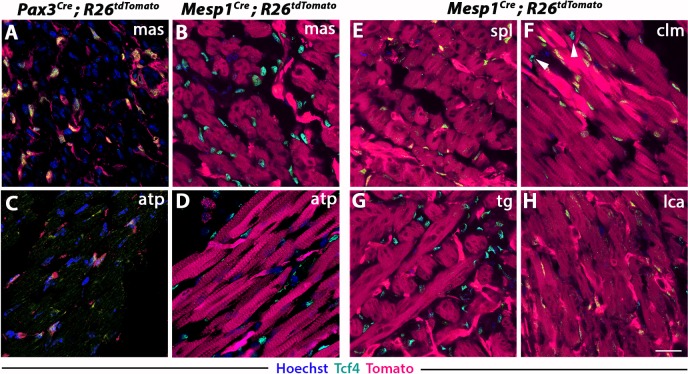
Contribution of Pax3 and Mesp1 lineages to connective tissue fibroblasts.Immunostainings of coronal cryosections (n = 2 each condition). (A–D) Tcf4+ cells derive from Pax3 but not Mesp1 lineage in the masseter and acromiotrapezius muscles. (E–H) MCT fibroblasts in splenius (epaxial muscle) (E), cleidomastoid (F) and lateral cricoarytenoid (laryngeal muscle) (H) originate from Mesp1 lineage, but little or no contribution is observed in tongue MCT (G). atp, acromiotrapezius; clm, cleidomastoid; lca, lateral cricoarytenoid; mas, masseter; spl, splenius; tg, tongue. Scale bars: in H for A-H 20 µm.